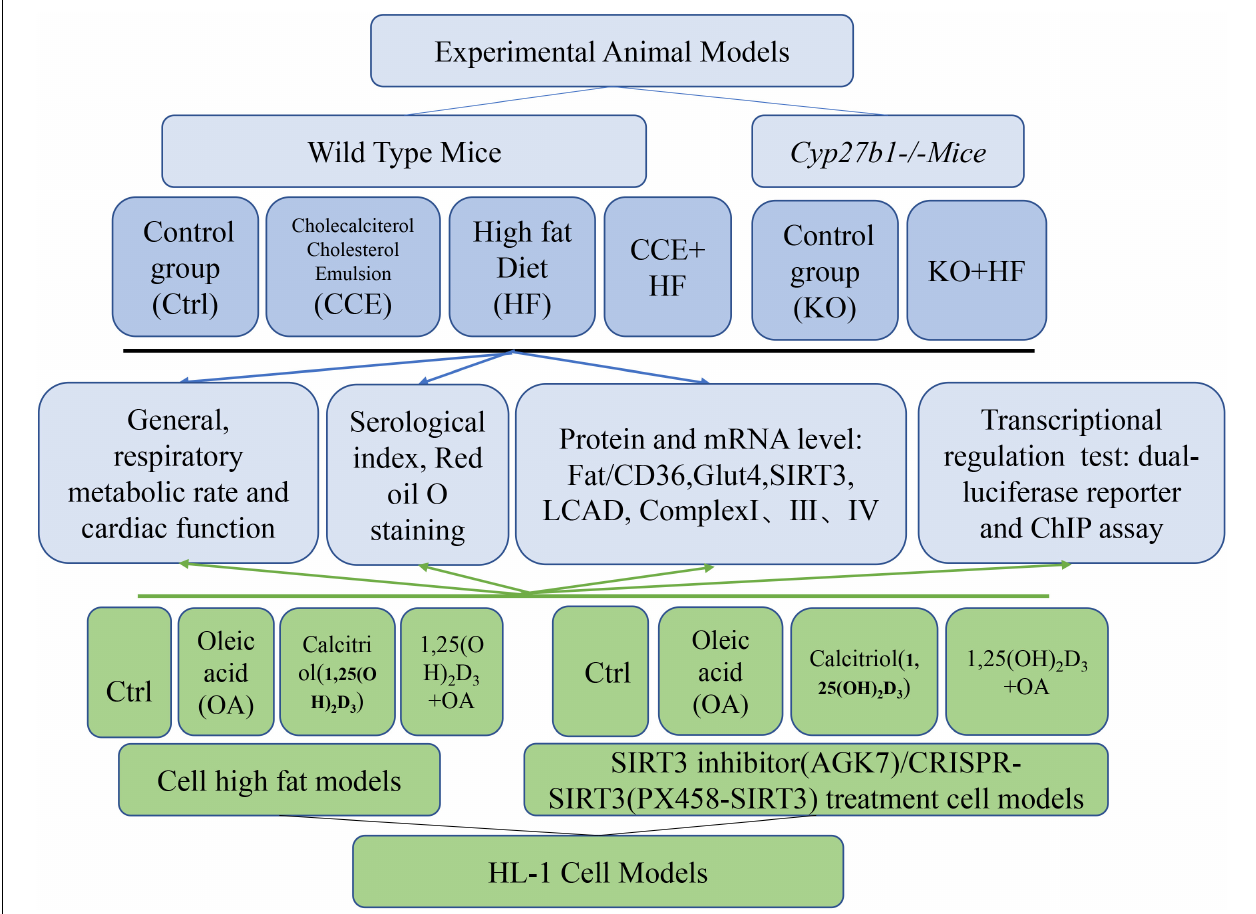
Rectal temperatures were measured at 4 p.m. using a rectal probe attached to a digital thermometer (Runjing Inc., TES-1310).